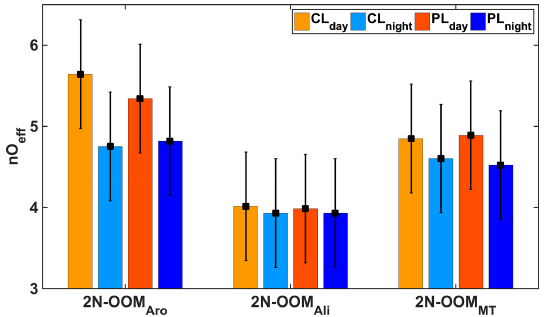
Figure 6. The nO eff of 2N-OOMs derived from different precursors in the four cases; the error bars represent the standard